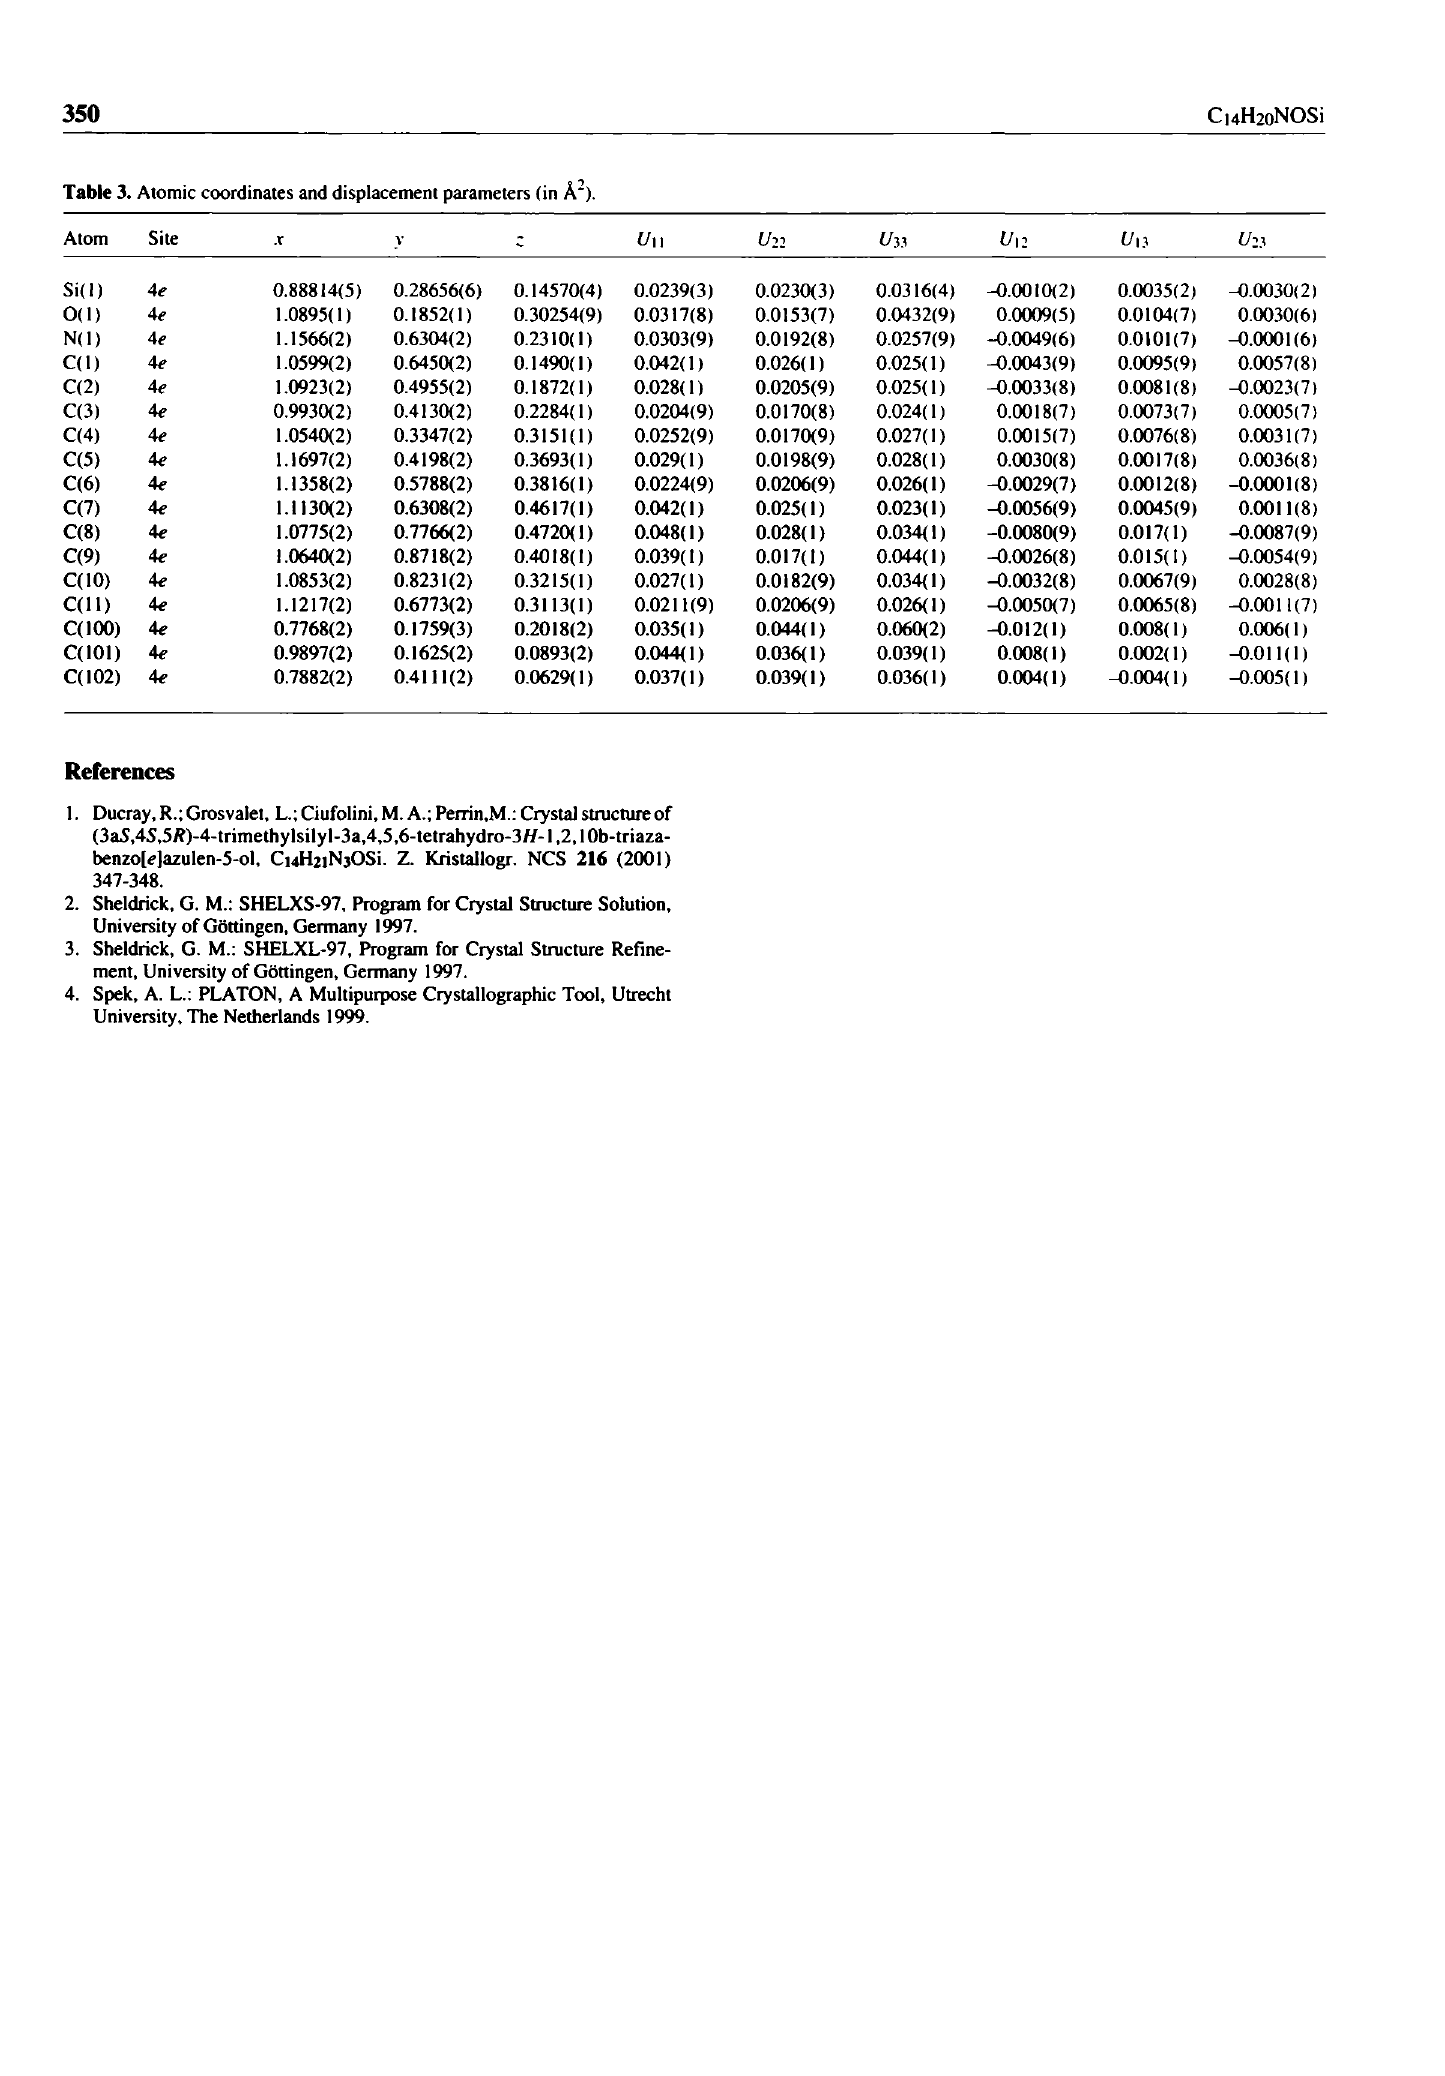
Table 3. Atomic coordinates and displacement parameters (in A 2